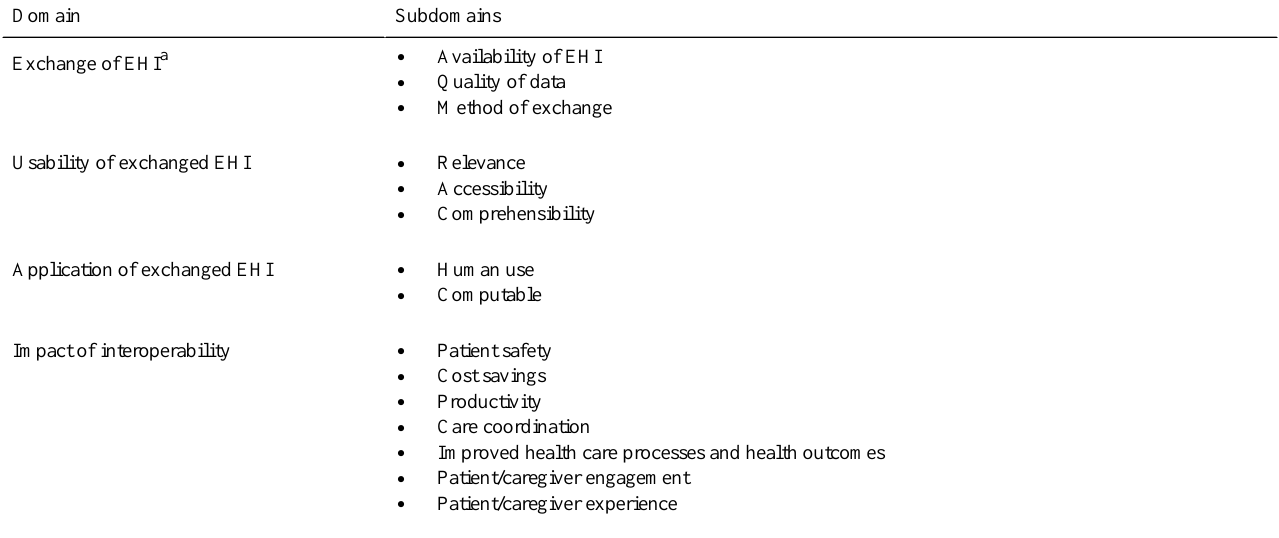
Table 1. National Quality Forum domains and subdomains of